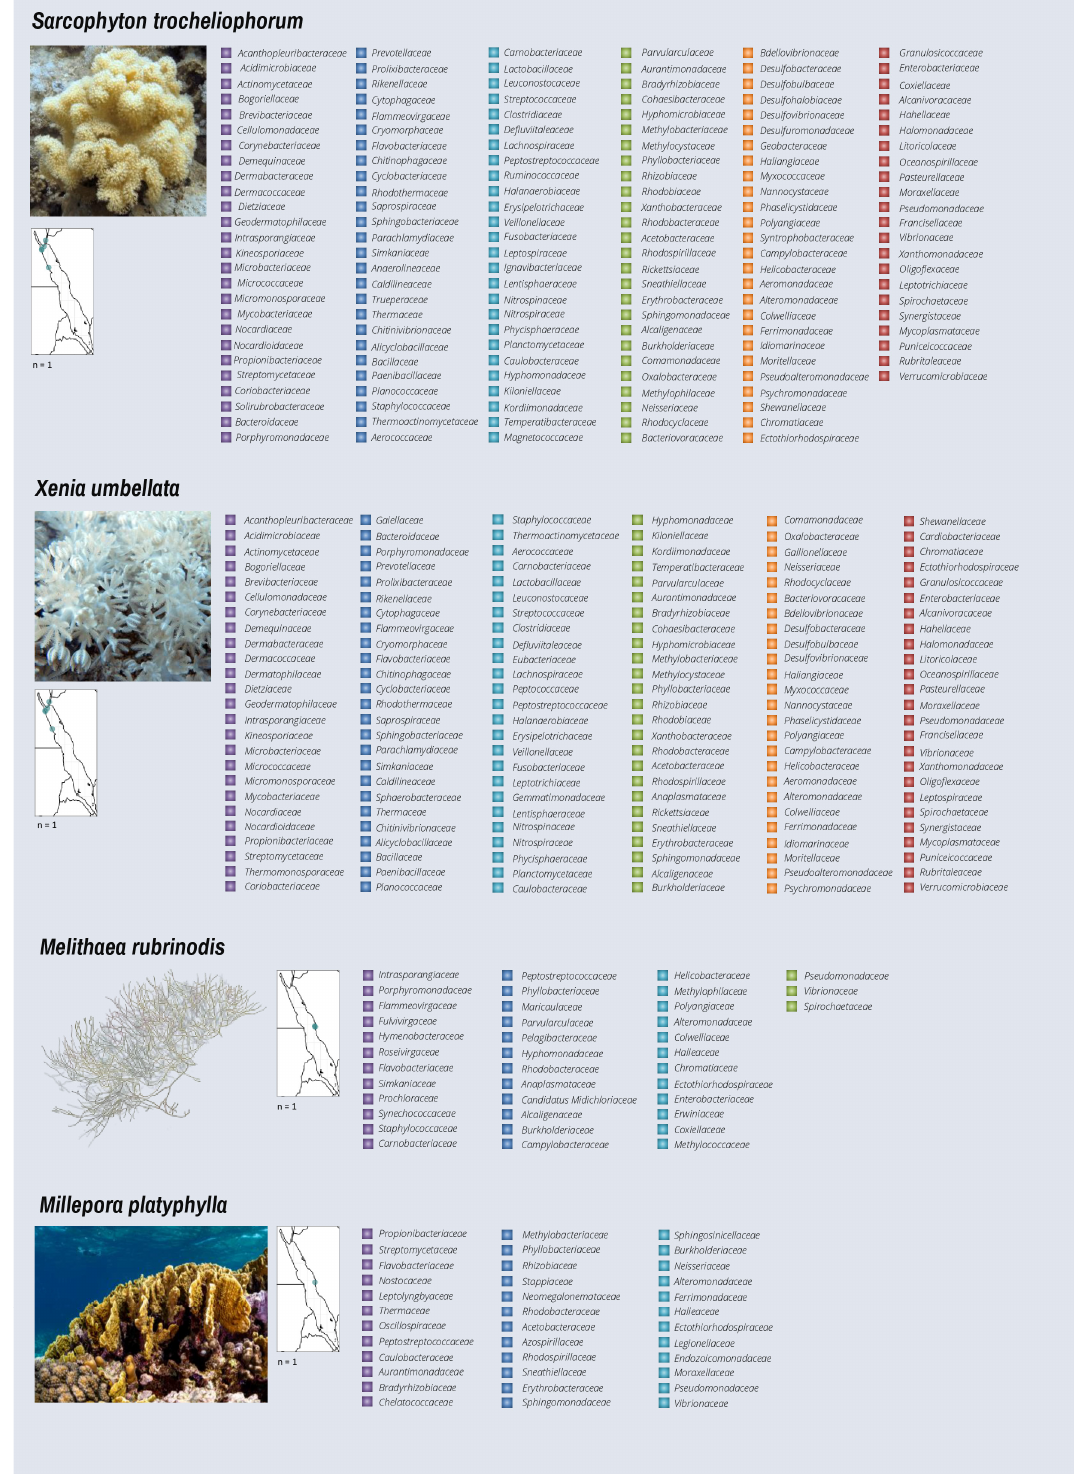
Figure 4. The Red Sea coral-associated bacterial Atlas: Coral-associated bacteria across Red Sea coral species. The reported families are shown. Due to space constraints, coral hosts are not presented by taxonomic classification, but rather by the overall abundance of associated bacterial families. The number of studies included for the Atlas, per coral species ( n ), and the corresponding location of the study sites in the Red Sea are indicated in the map inset close to the image in vivo.